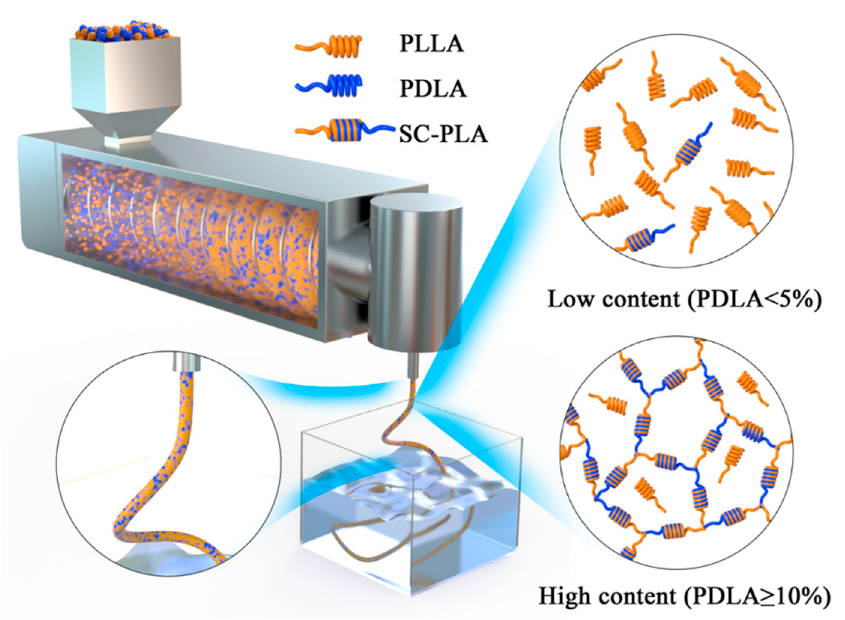
Figure 5. Mechanism for formation of a cross-linking network of SC crystals.